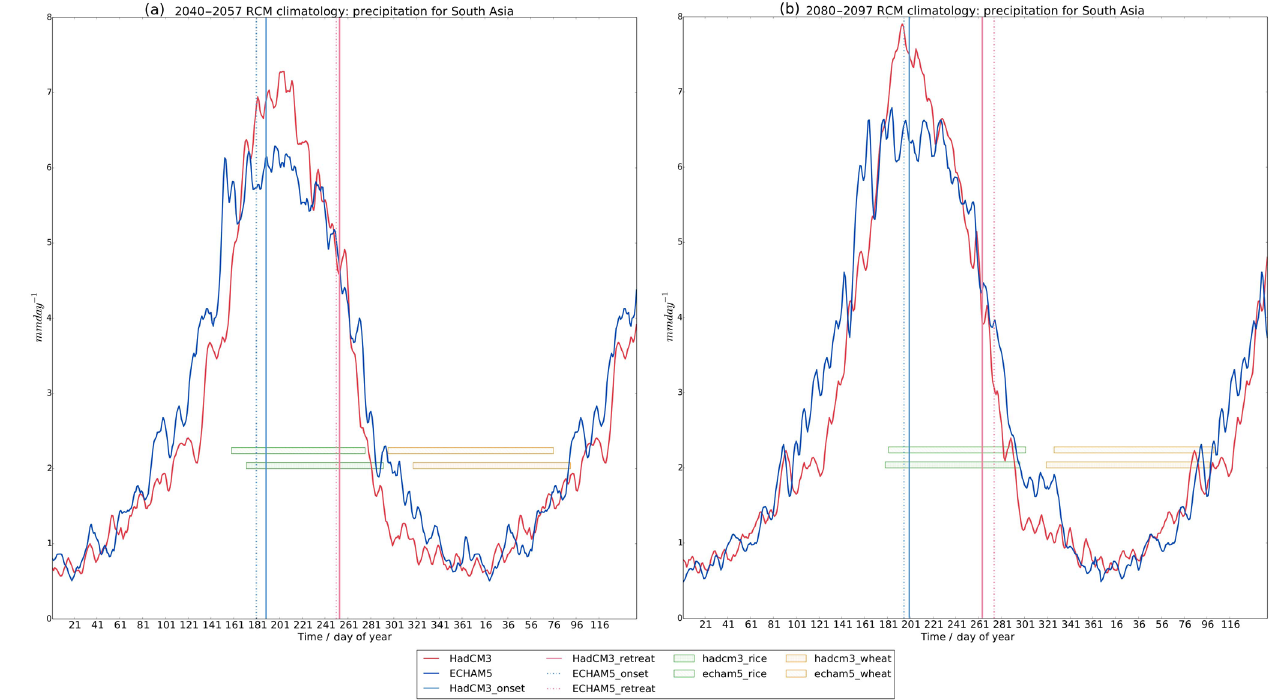
Figure 11. The 1.5-year precipitation climatology for the period 2040–2057 (a) and the 2080–2097 (b) averaged for the whole of South Asia for each simulation (HadCM3-red line, ECHAM5-blue line) using a 5-day smoothed rolling mean. Also shown are the monsoon-derived growing seasons for wheat (orange) and rice (green) calculated using the method described in Fig. 2 for HadCM3 (upper rectangle with perpendicular hatching) and ECHAM5 (lower rectangle with diagonal hatching). The monsoon onsets for each simulation are shown using blue vertical lines and retreats using pink vertical lines (ECHAM5-dash dot lines, HadCM3-solid).